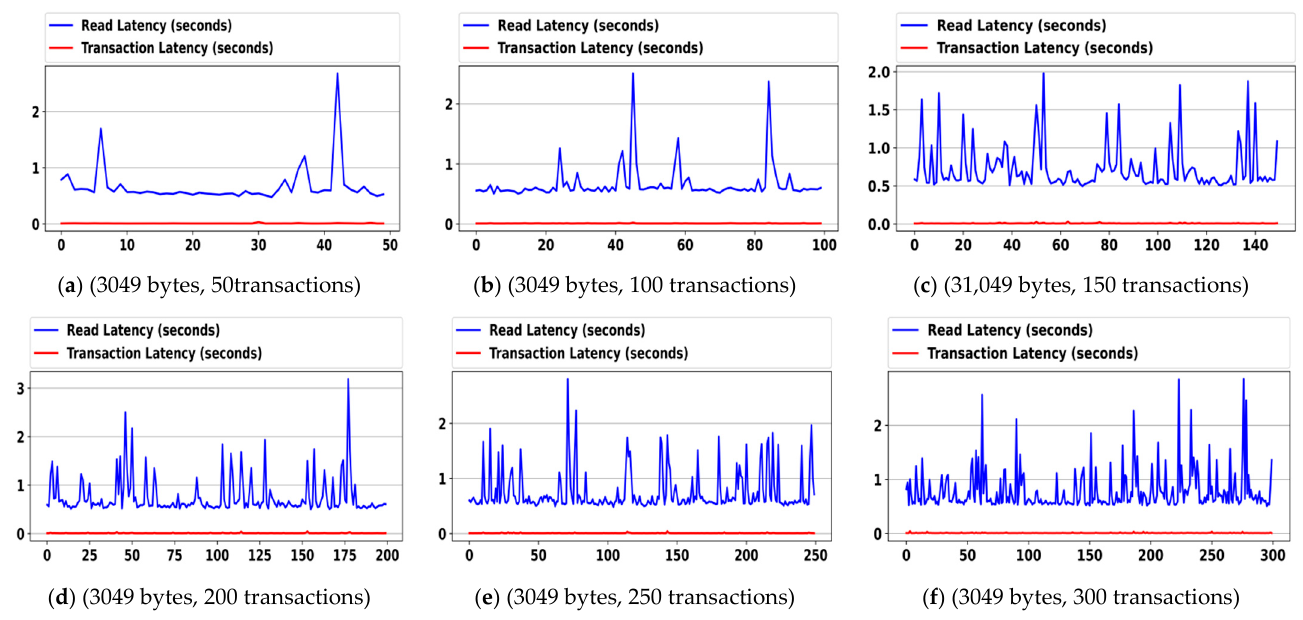
Figure 6. Impact of the transactional data size, 3049 bytes on RL, and TL for ( a ) 50, ( b ) 100, ( c ) 150, ( d ) 200, ( e ) 250, and ( f ) 300 transactions. Table 4. Results of the impact of the transactional data size 1049 bytes on RT, and TT according to the number of satellite transactions.